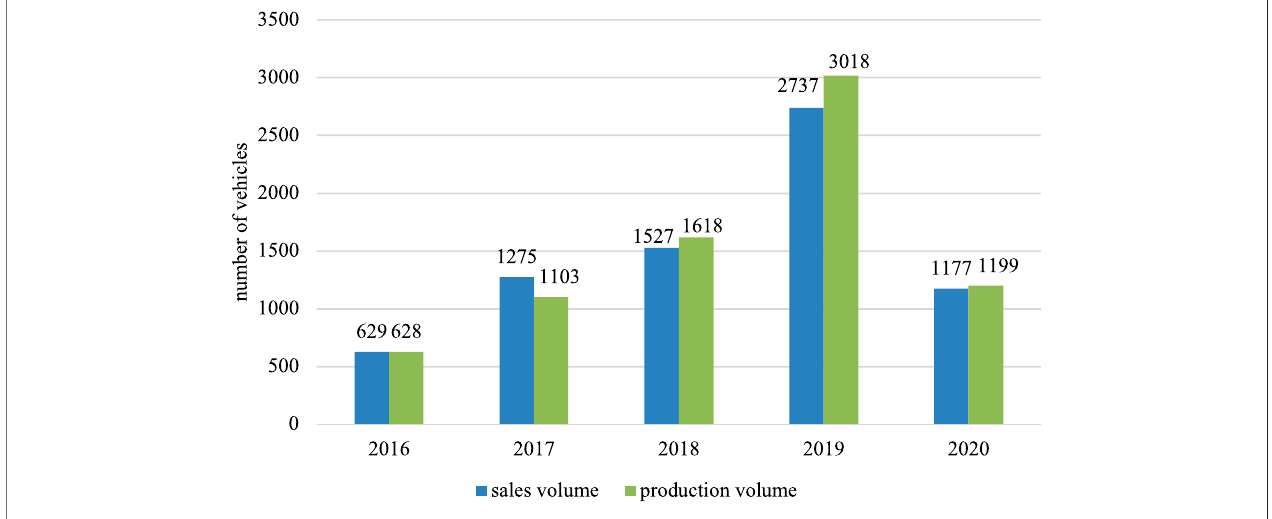
FIGURE 1 | Comparison on production and sales of HFCV in China (2016 – 2020). Data source: China Auto Parts industry Association.